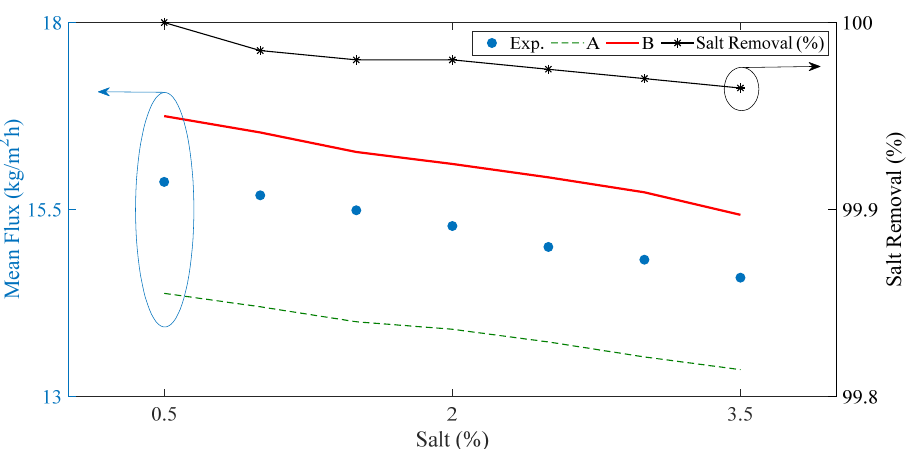
Figure 8. The permeate flux versus feed salinity with experimental and analytical (( A ): with spacer; ( B ): without spacer) results.